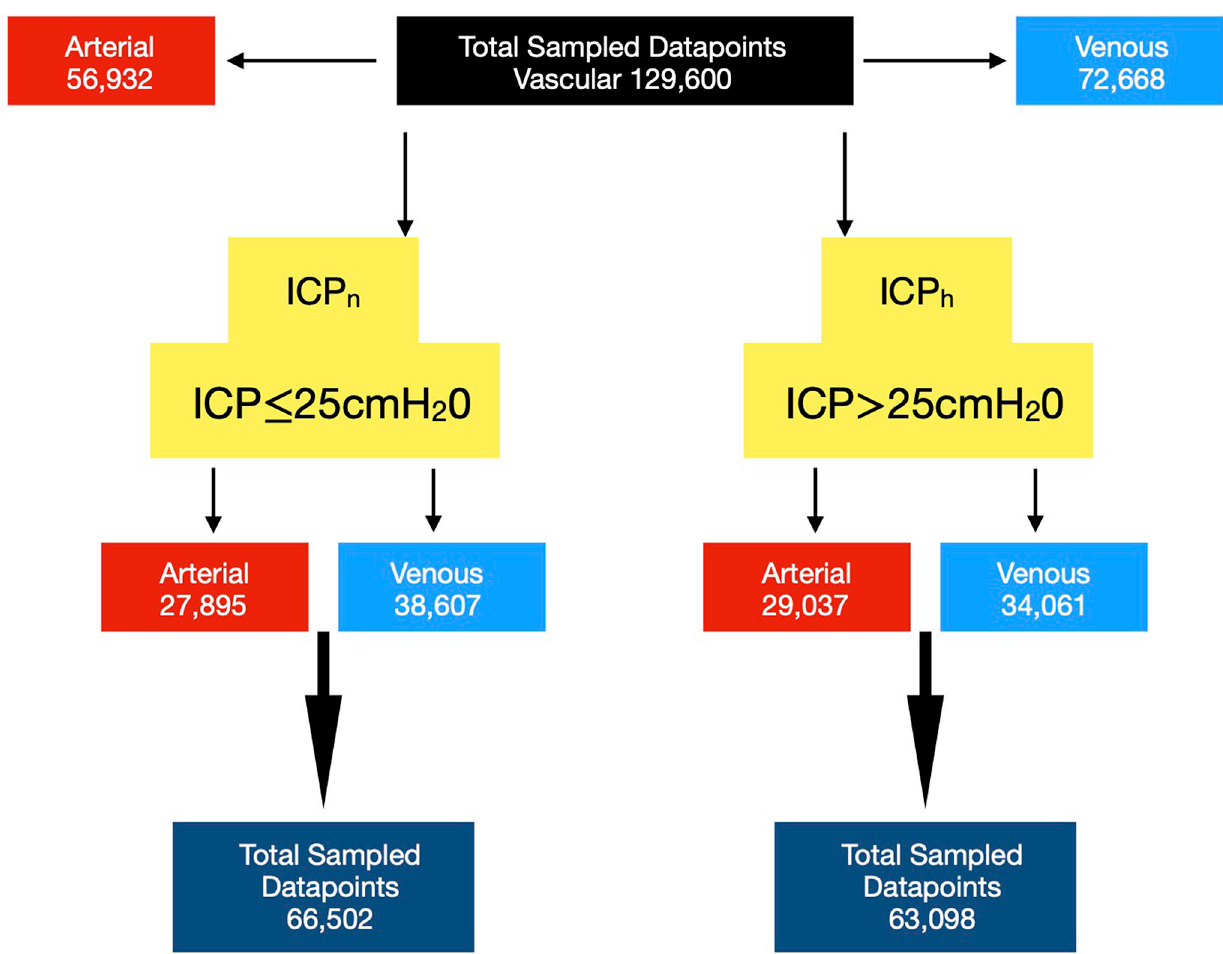
Fig 2. Data points from training and test study groups. The data points are sub-classified into arterial and venous points, in patients with normal intracranial pressure